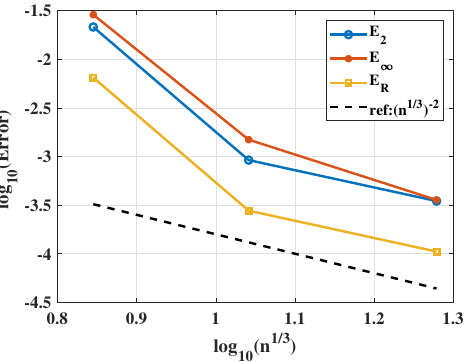
Figure 5. Diagram of the DoFs vs. the error between the numerical and analytical solutions in 3D.